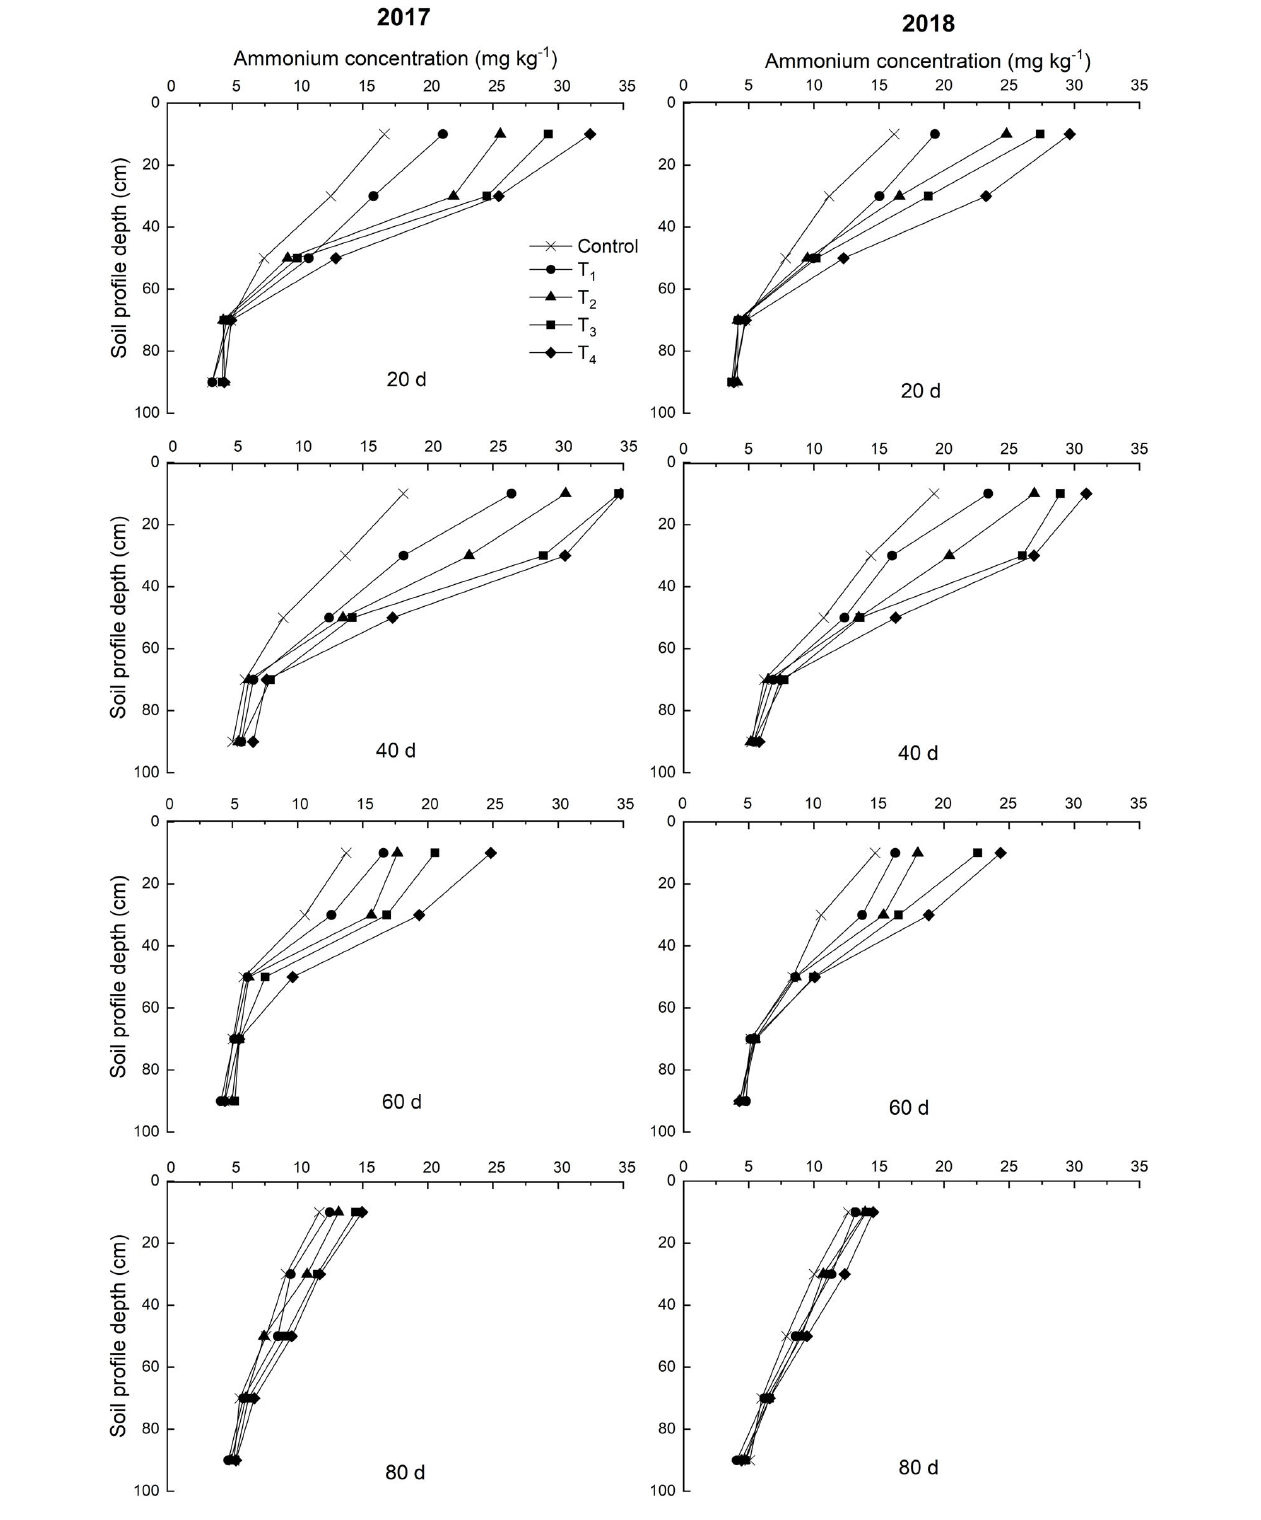
FIGURE 3 | Effects of DMPP on the dynamic of NH 4 + -N concentration of soil in 2017 and 2018.